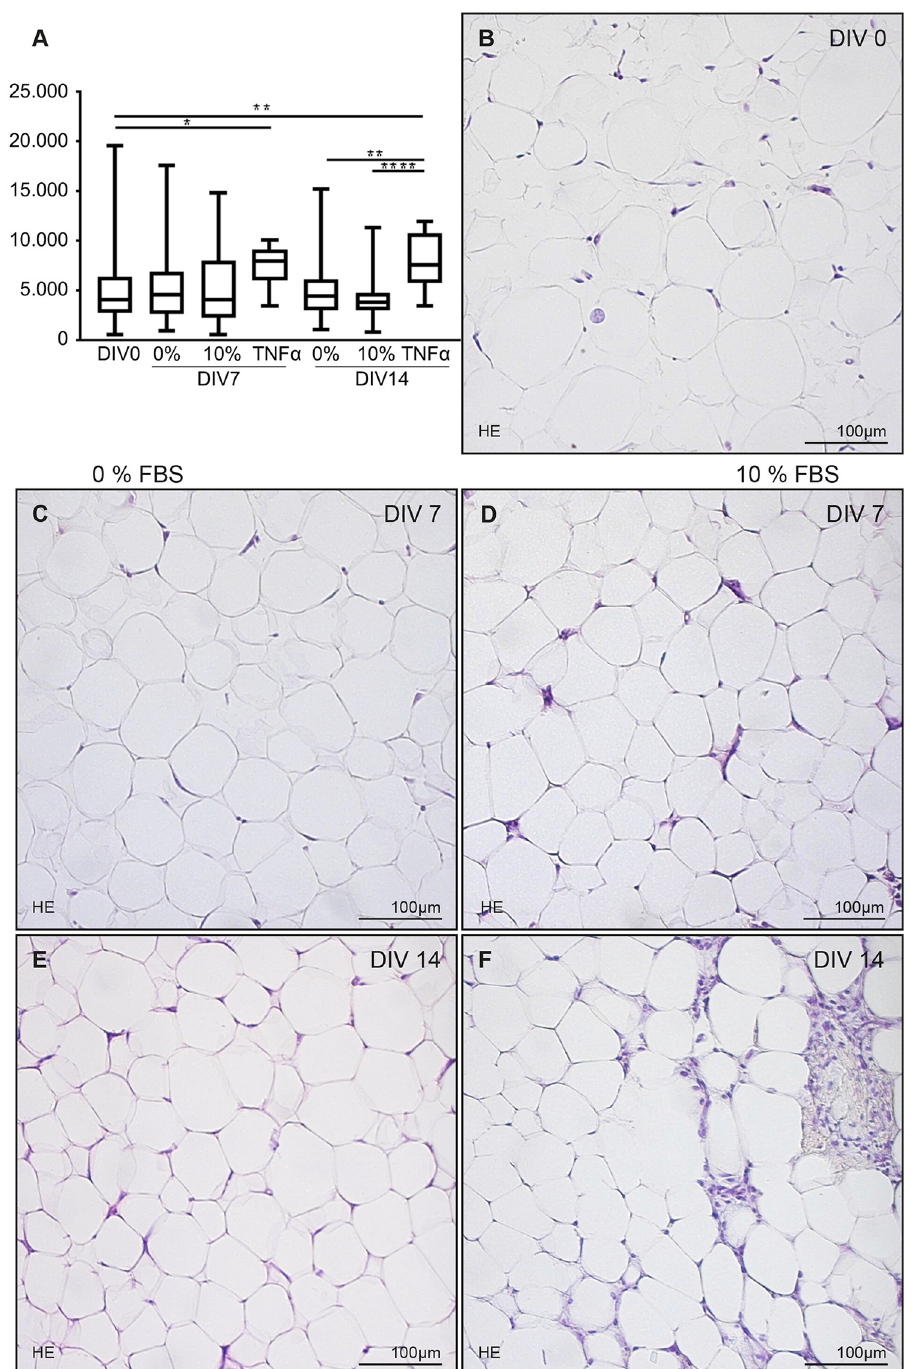
Fig 3. Tissue analysis. A—No measurable difference in the cross-section area of adipocytes in medium with and without 10% FBS, but TNF α supplementation increased the cross-section area of adipocytes (y-axis in μ m 2 ). Morphological analysis was performed via H/E staining and showed well-sustained AT. B—0 th DIV. C & D—7 th DIV. E & F—14 th DIV. Left column—0% FBS. Right column—10% FBS.